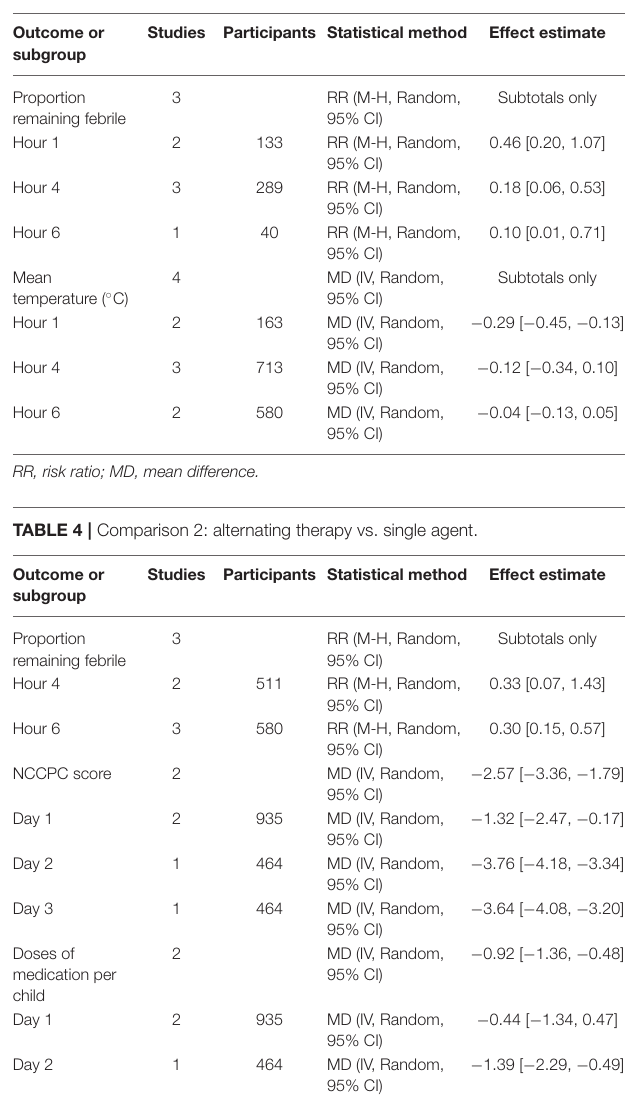
TABLE 3 | Comparison 1: combined therapy vs. single agent.